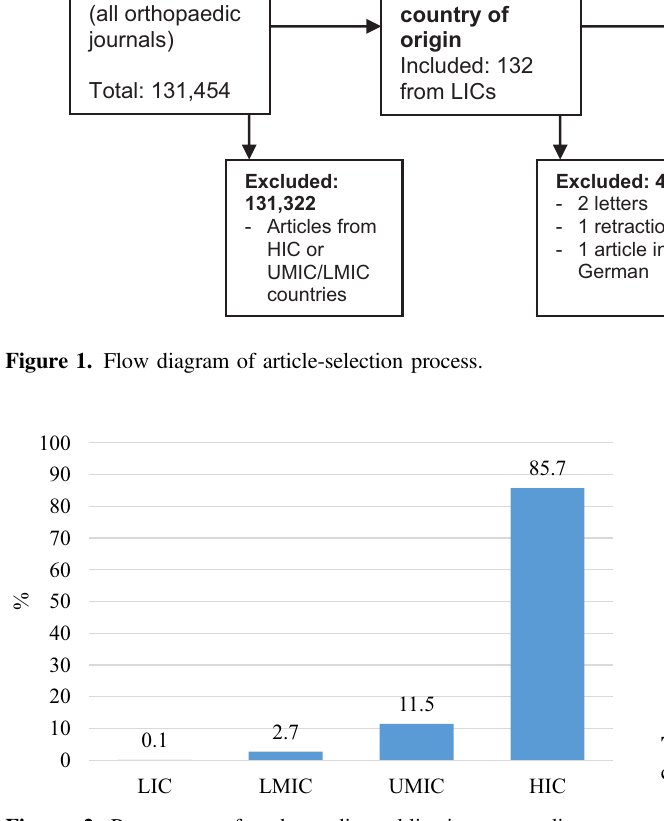
Figure 2. Percentage of orthopaedic publications according to country income level.